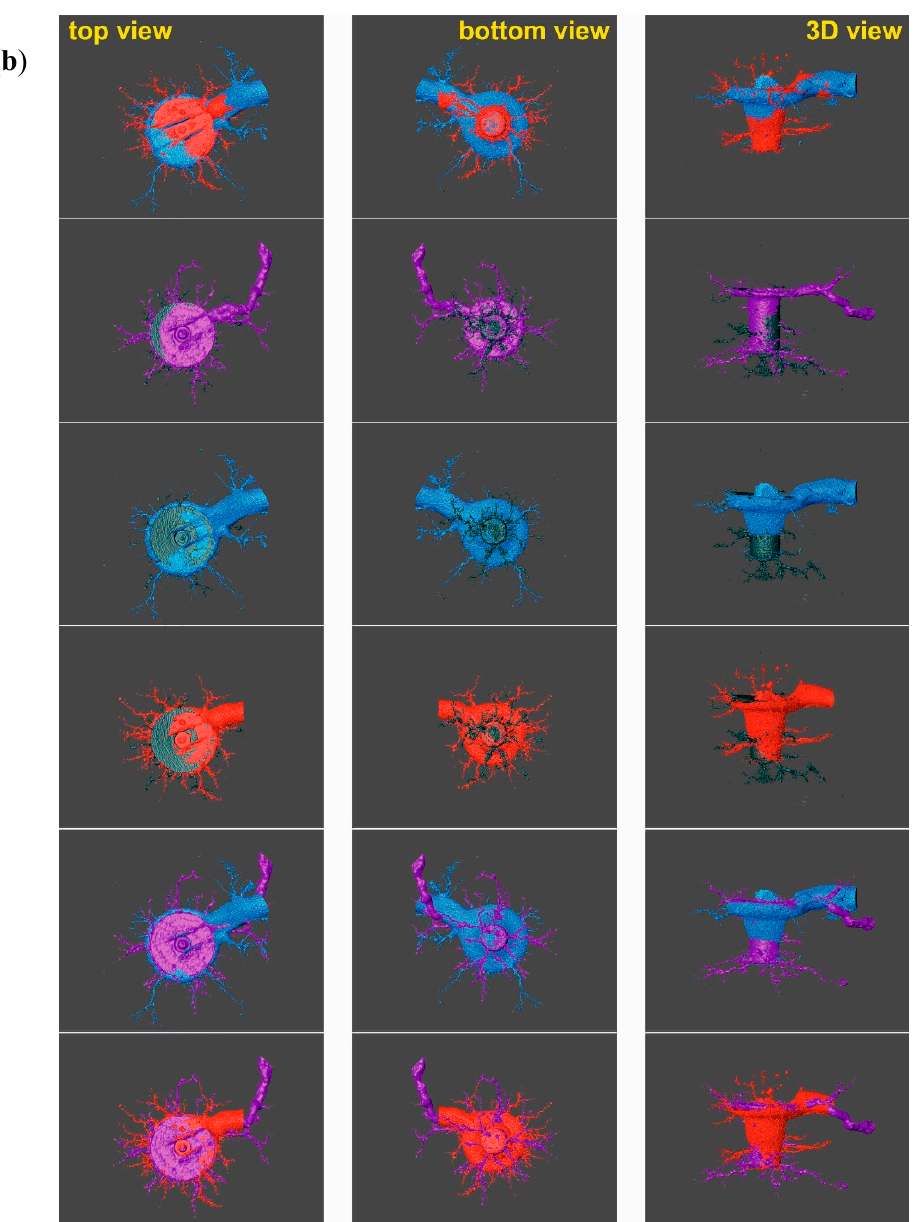
Figure 2. ( a ) Computed Tomography (CT) scan of injection well vicinity before and after injection of CO 2 -rich solution. Notice the development of a dissolution network with one dominant wormhole (pink) after 10 days of injection; ( b ) comparison of obtained dissolution arrays (top views, bottom views, and 3D models) based on CT scan results in pairs of experiments. Different colors correspond to the experiment number: Grey is #1, purple is #2, red is #3, and blue is #4. Vertical columns of images correspond to: Left –top view in horizontal plane; middle –bottom view in horizontal plane; right –side 3D view in vertical plane.